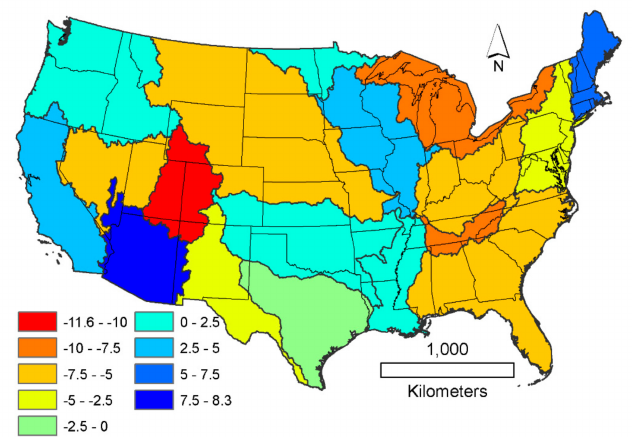
Figure 14. Spatial distribution of the estimation errors (mm dec − 1 ) in the linear tendencies for the HUC2 annual PRISM precipitation rates (1979–2015).